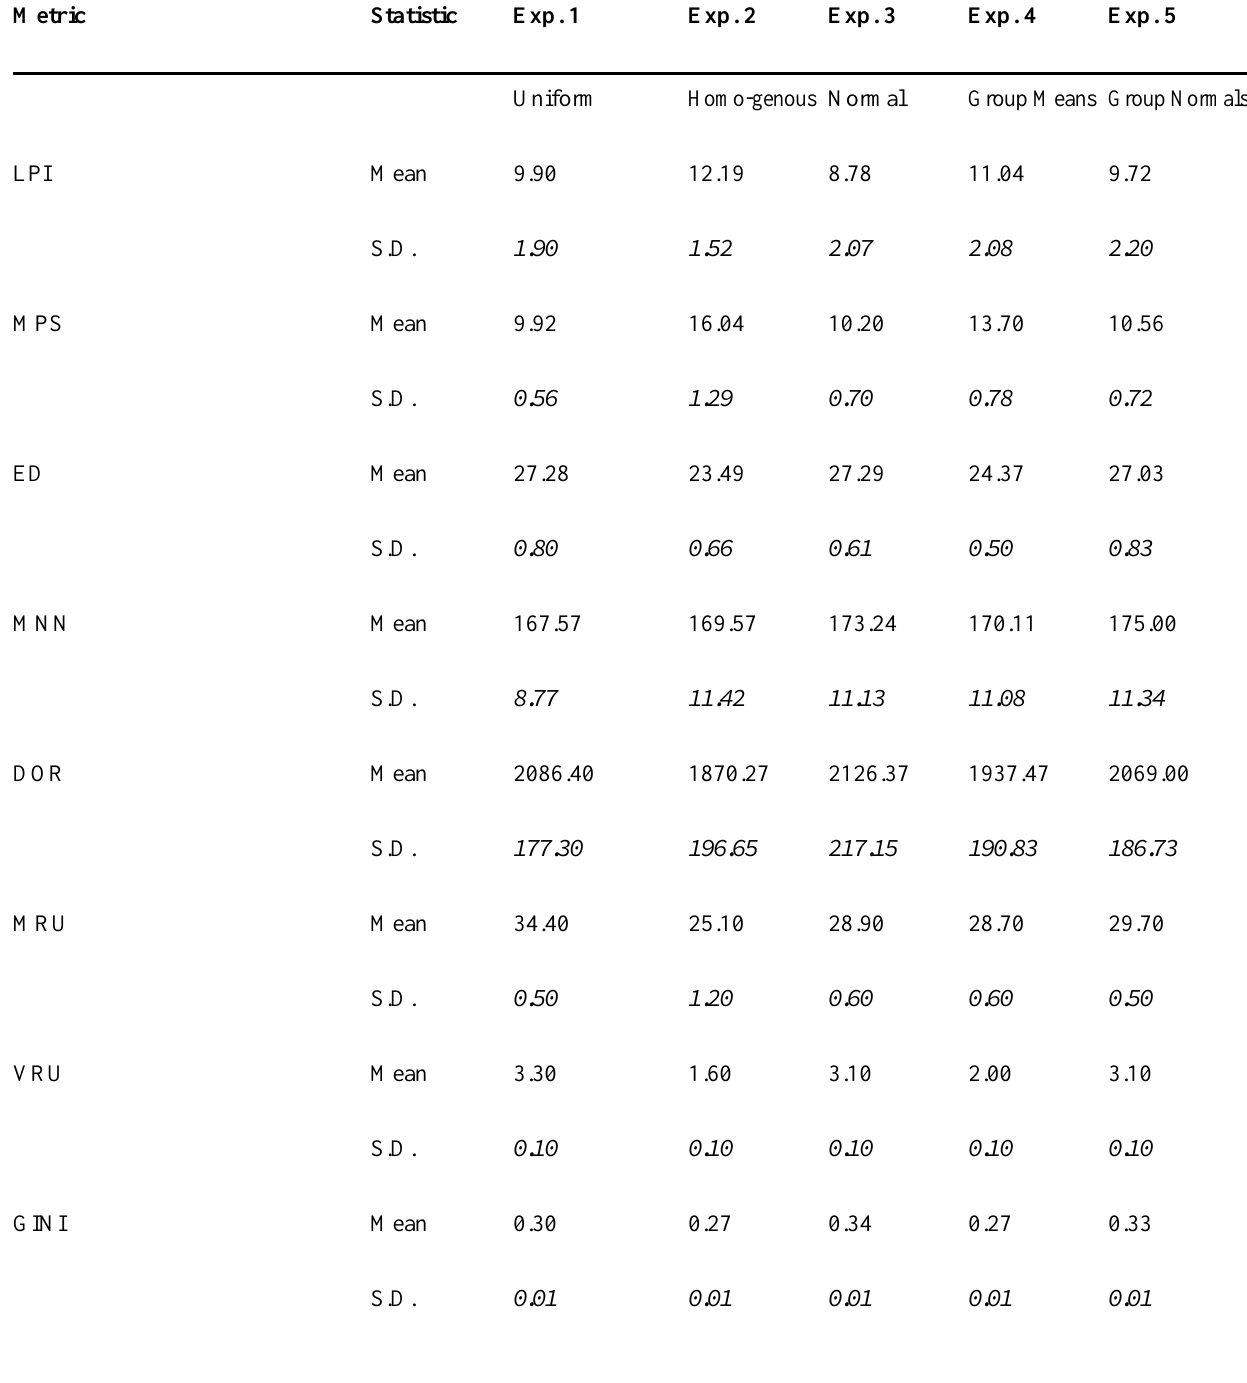
Table 4. Means and standard deviations (S.D.) of metrics describing spatial patterns of development and utility distributions, calculated across 30 runs of the SOME model with agent preferences input in each of five experimental